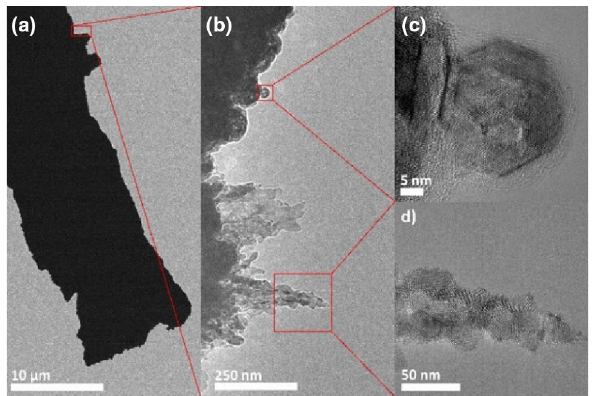
Figure 8. Bright-field TEM micrographs of laser-sintered FeRh. ( a ) Overview of laser-sintered flake. ( b ) Bright- field image showing spherical particles and dendritic formations. ( c ) HR-TEM of a single spherical particle, sintered to the surface of the flake. (Compare Suppl. Fig. S5) ( d ) HR-TEM of a dendrite composed of multiple crystallites.